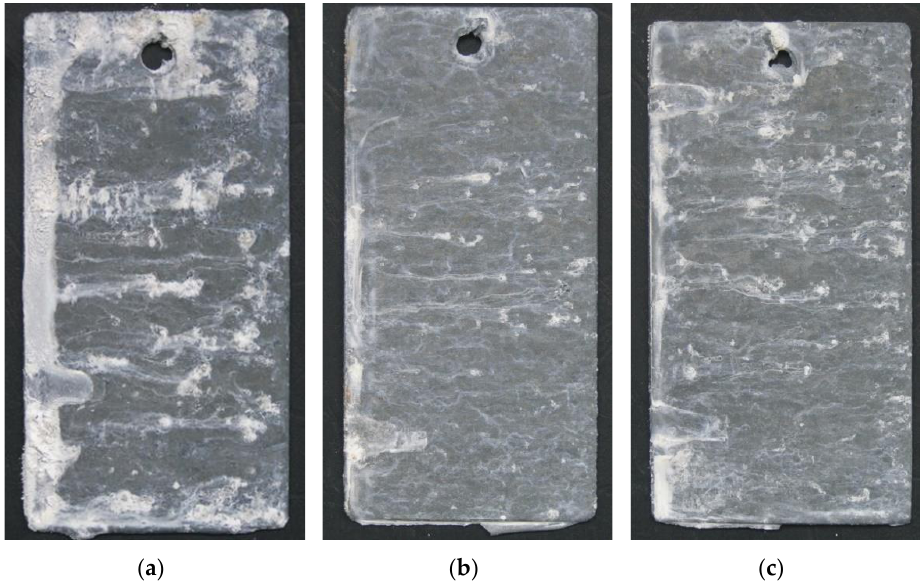
Figure 9. The appearance of the surface of research coatings obtained in the: ( a ) ZnAl23Si0.4, ( b ) ZnAl23AlMg3Si0.4, and ( c ) ZnAl23AlMg6Si0.4 bath after 1500 h of exposure in neutral salt spray test.